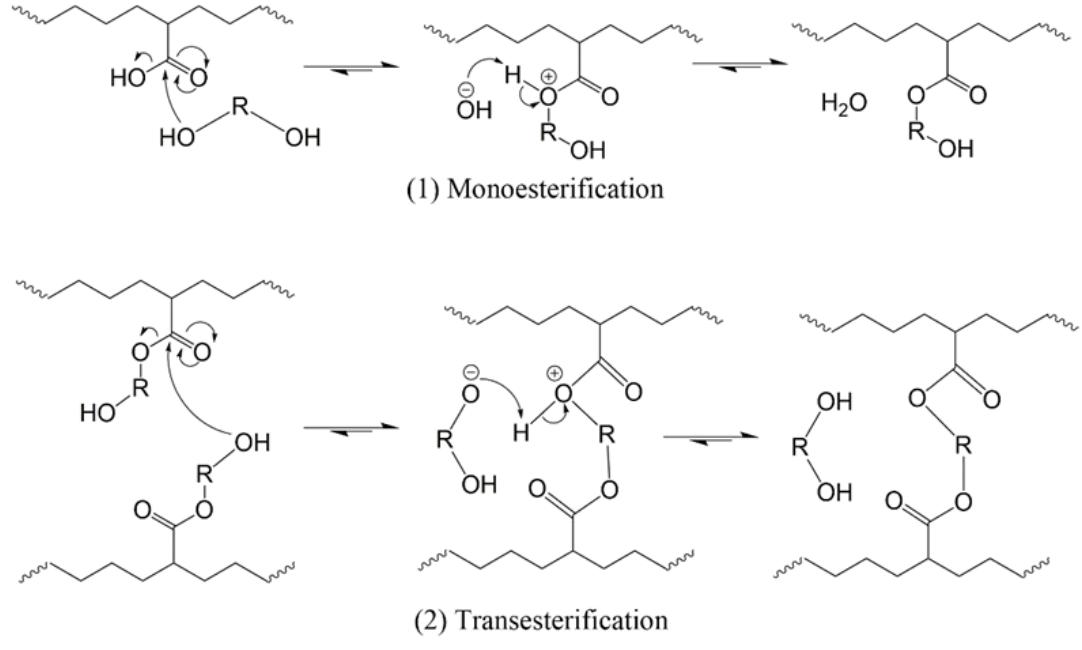
Figure 2. The scheme proposed for diols crosslinking with hydroxyl-containing polyimides through monoesterification and transesterification. monoesterification and